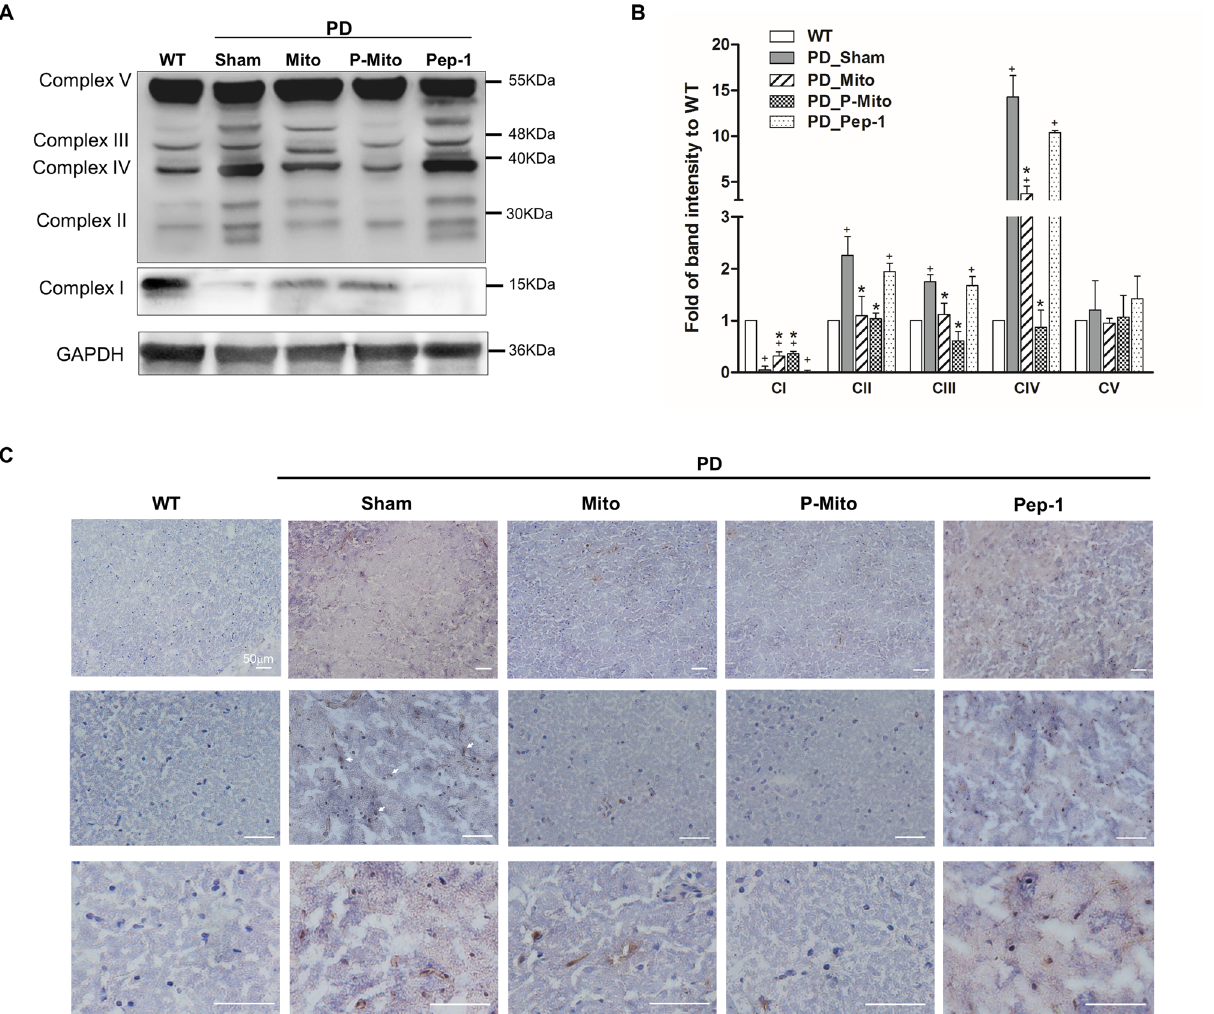
Figure 4. Normalized expression profiles of mitochondrial complexes in lesioned substantial nigra (SN) document subsequent attenuation of oxidative stress. ( A ) Mitochondrial integrity in the SN of the midbrain after 3 months of treatment was assessed and ( B ) quantified based upon protein levels of mitochondrial respiratory chain complexes I–V in same PAGE gel, normalized against an internal control, glyceraldehyde 3-phosphate dehydrogenase (GAPDH), with same amount of loading protein. Changes in the patterns of mitochondrial proteins, including band intensity and molecular weights, relative to wild-type controls, are presented. For whole uncropped images of original western blots with three independent samples of each group, please refer to Supplementary Figure (Fig. S1). ( C ) Immunohistological stain for 8-hydroxy-2’-deoxyguanosine (8-OHdG), a marker of DNA oxidative damage, was performed to examine DNA oxidative damage in the SN. Brown color indicates specific immunostaining of 8-OHdG (as depicted by arrows at high magnification, lower panels). Blue dots indicate nuclear haematoxylin staining. + P < 0.05, vs. WT; * P < 0.05, vs. Sham; WT wild-type controls, PD Parkinson’s disease, Sham vehicle alone, Mito mitochondrial alone, P-Mito Pep-1-labelled